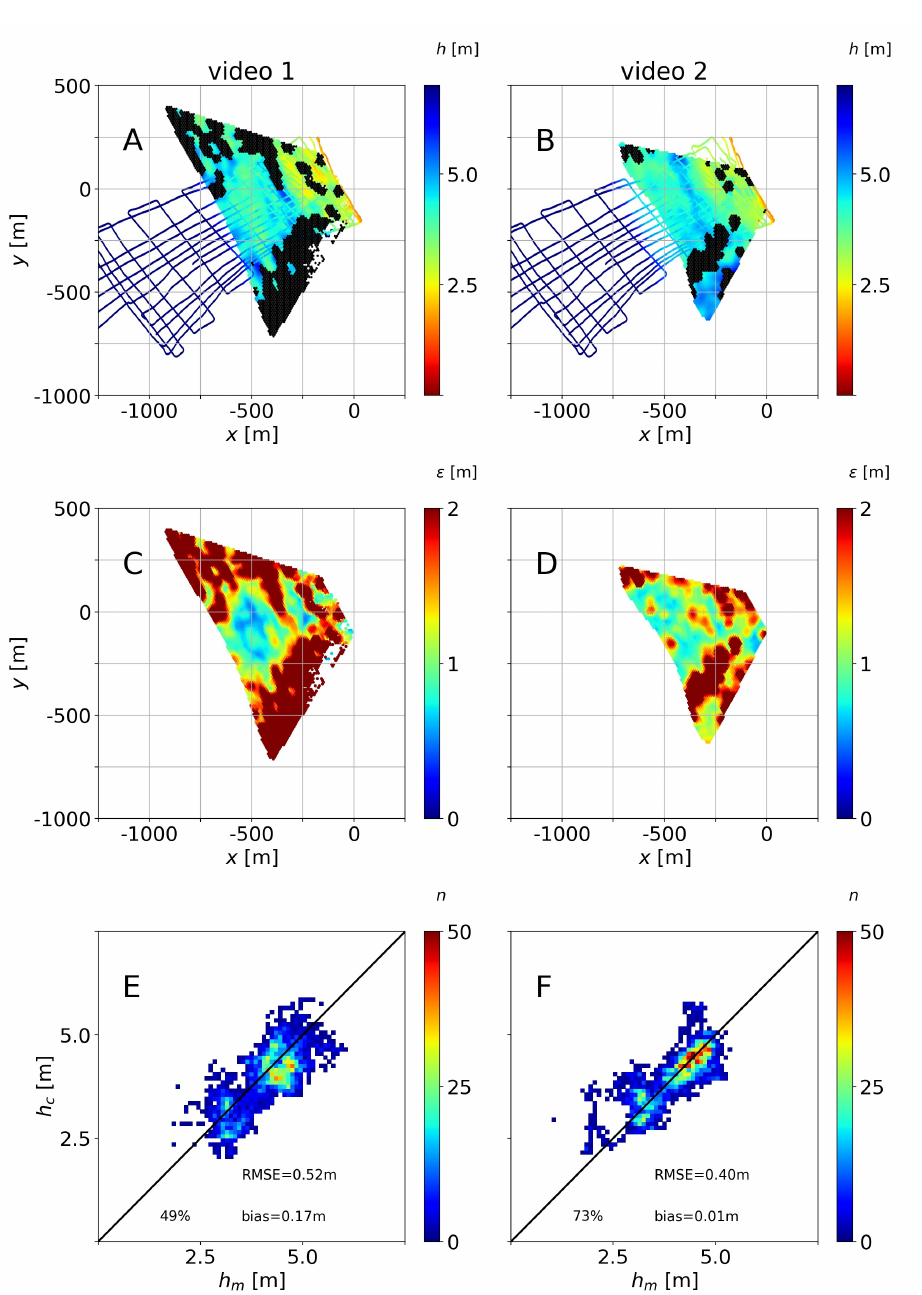
Figure 11. Bathymetry estimation for n I = 5 and t f = 5 s for videos 1 ( A , C , E ) and 2 ( B , D , F ): retrieved water depth and ground truth water depth for the boat path ( A , B ), errors ε ( C , D )—points with ε > ε 0 = 2 m are black-masked in plots A and B; measured ground truth, h m , and computed, h c water depths for the boat path for ε (cid:54) ε 0 (E and F, where n stands for the number of observations at each